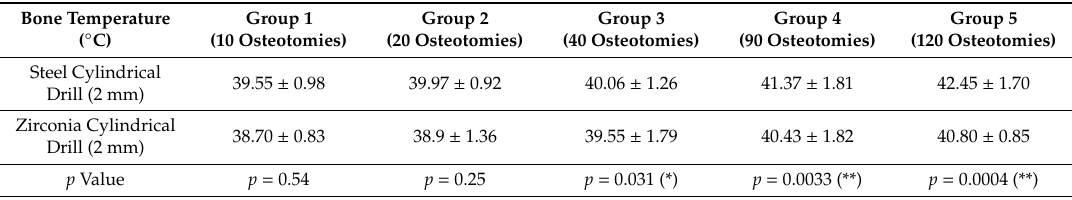
Table 1. Summary of the cortical bone temperature after drilling site preparation (mean ± standard deviation).